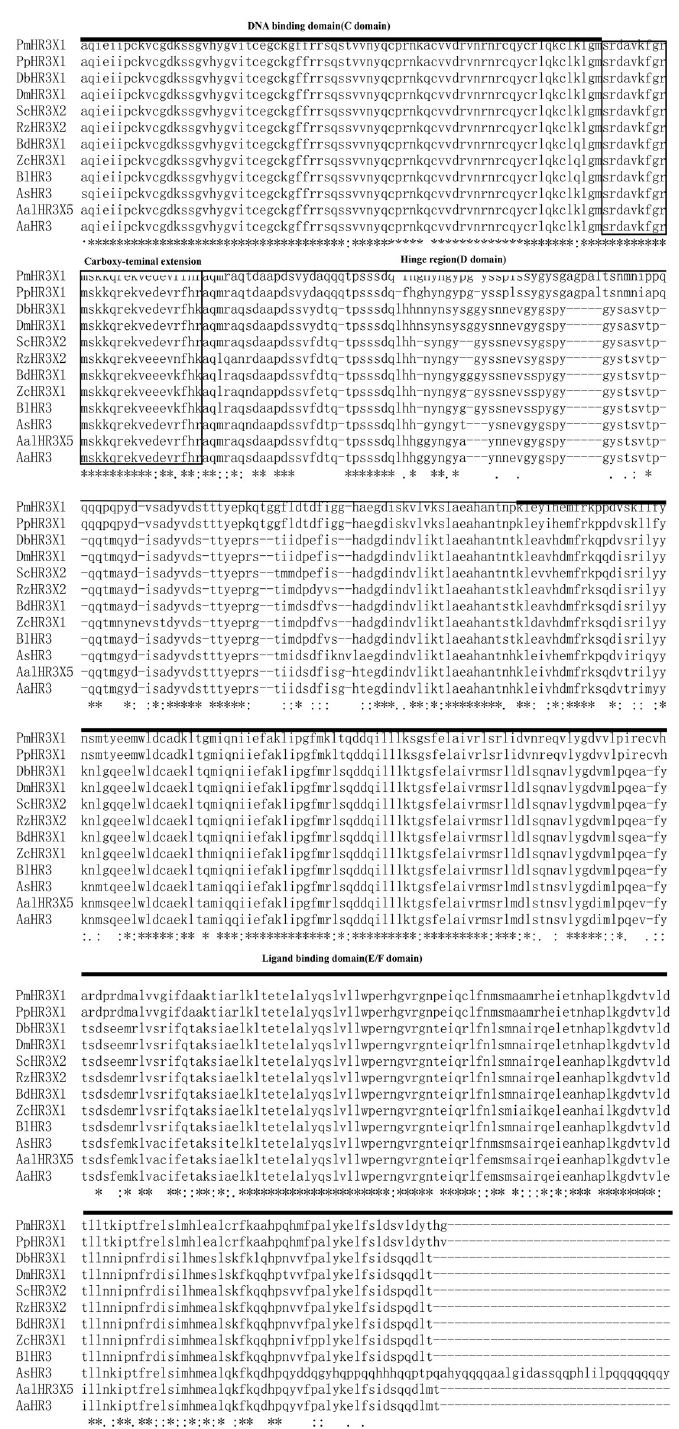
Fig 1. Amino acid sequence alignment of Aedes aegypti HR3 with its homologs. Sequences are from Papilio machaon (PmHR3X1, XP_014364014), Papilio polytes (PpHR3X1, XP_013136657), Drosophila biarmipes (DbHR3X1, XP_016947144), Drosophila Miranda (DmHR3X1, XP_017149048), Stomoxys calcitrans (ScHR3X2, XP_013103855), Rhagoletis zephyria (RZHR3X2, XP_017466500), Bactrocera dorsalis (BdHR3X1, XP_019847140), Zeugodacus cucurbitae (ZcHR3X1, XP_011182274), Bactrocera latifrons (BlHR3, XP_018799932), Anopheles sinensis (AsHR3, KFB44899), Aedes albopictus (AalHR3X5, XP_019549827), and Aedes aegypti (AaHR3, AF230281, AAEL009588-PA).